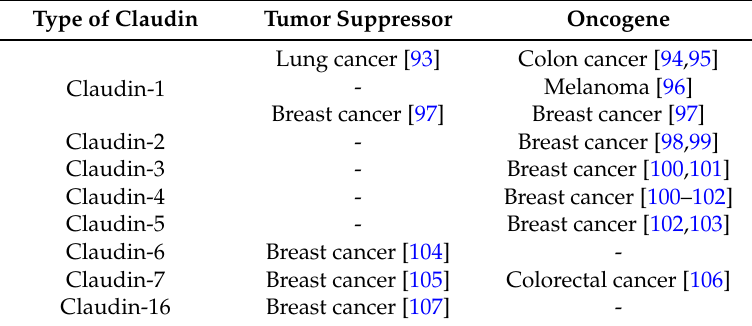
Table 1. Putative roles of claudins in various